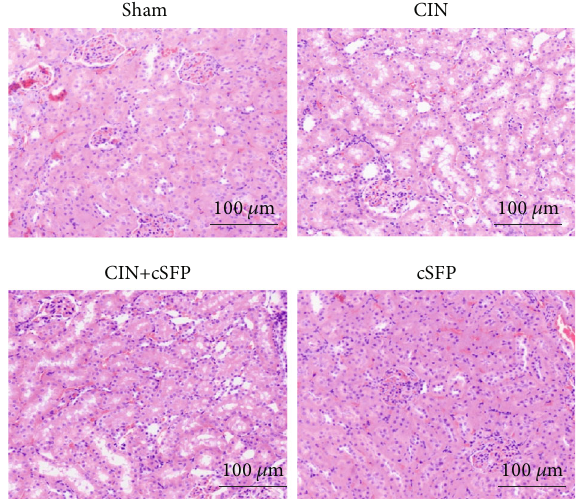
Figure 6: cSFP pretreatment attenuated the renal pathological damage in kidney tissues of CIN rats. Renal histological sections by H&E staining at 24h CIN induction